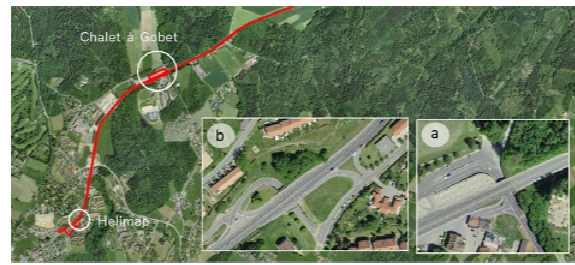
Figure 5: Trajectory for testing Puck-APX15 mobile mapping devices with respect to a reference (Riegl-IGI).